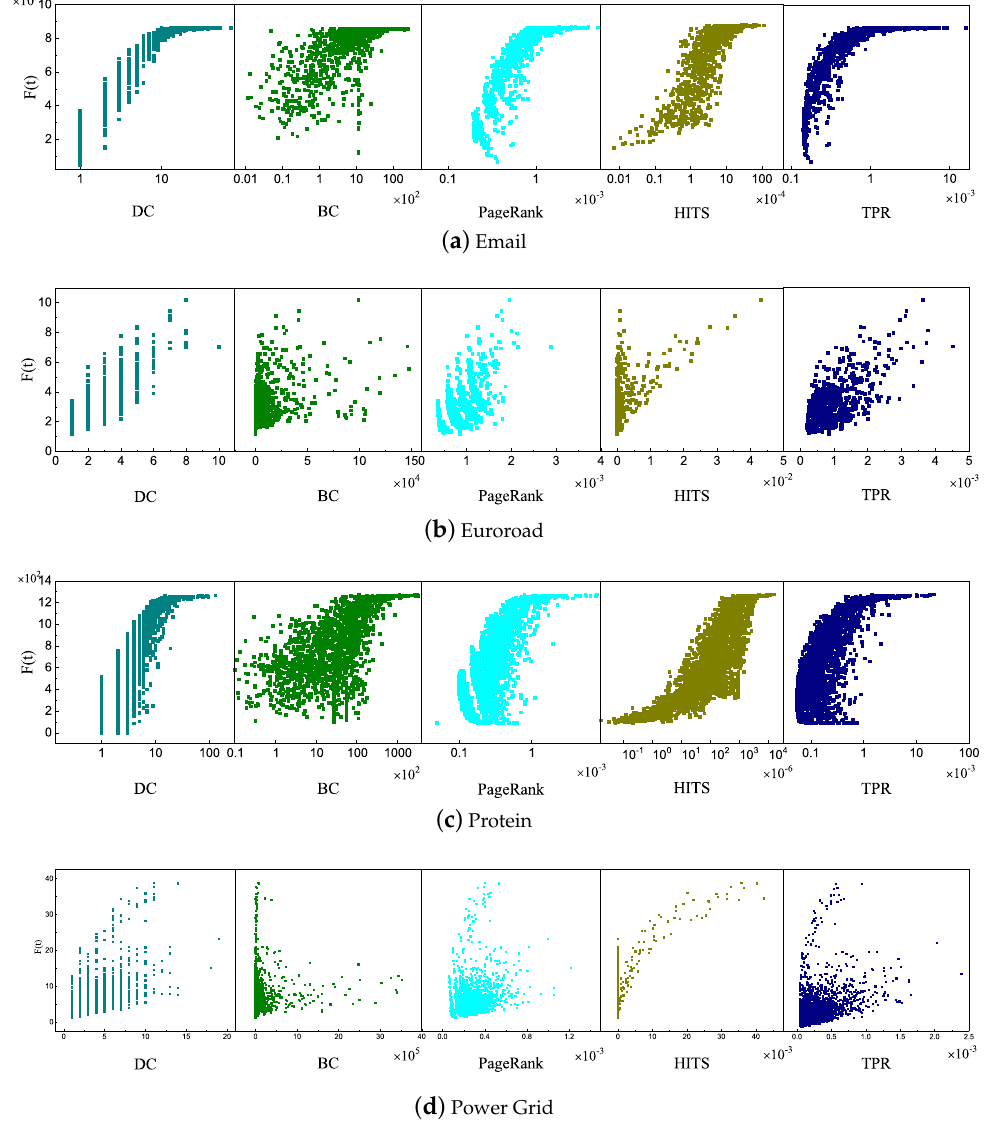
Figure 6. Comparison between the central value and the propagation ability of SIR. The horizontal axis represents the node influential value obtained by each algorithm and the vertical axis is the propagation capability F ( t ) of the corresponding node evaluated by the SIR propagation